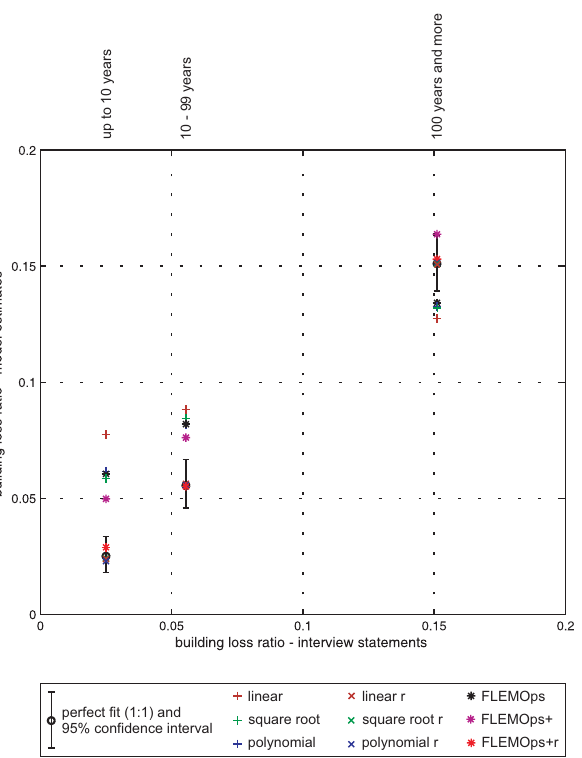
Fig. 7. Model estimates and interview answers for five water level